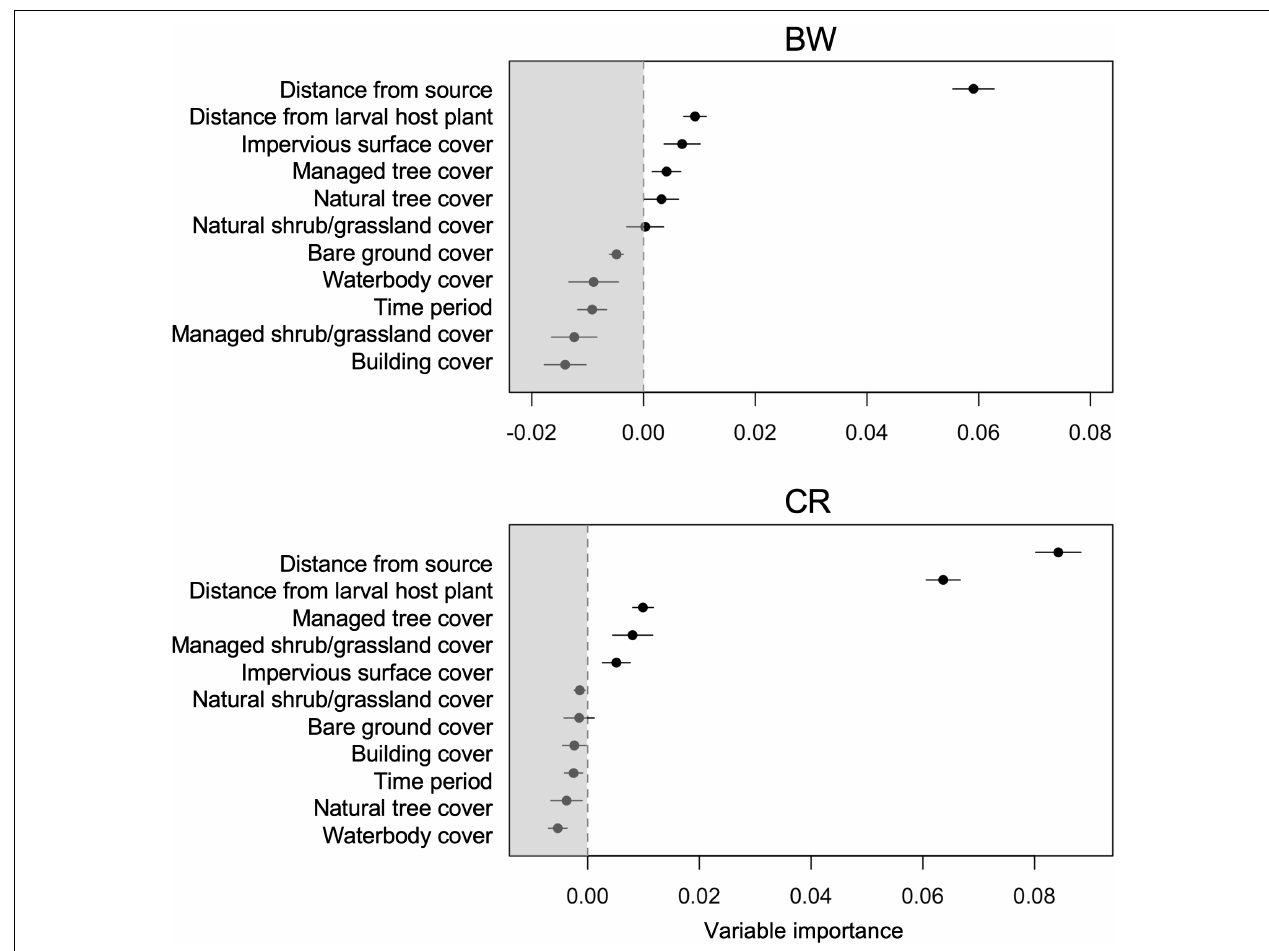
FIGURE 3 | Relative importance of habitat and life-history parameter values on the occurrence of BW and CR butterfly species in the random forest model. Error bars are 95% confidence intervals.